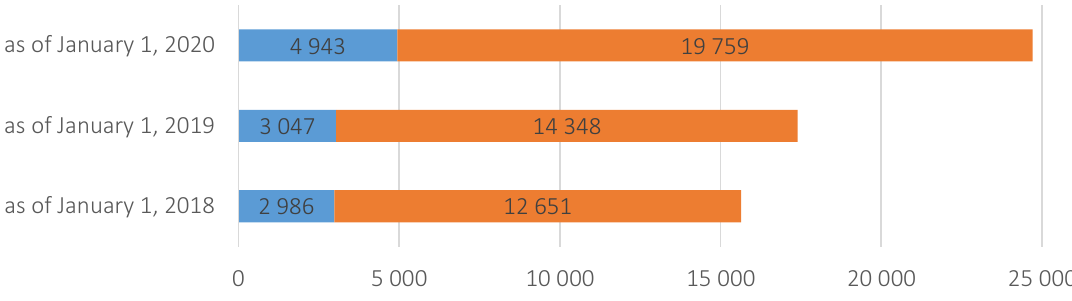
Figure 4. Number of warnings from the State Treasury Service of Ukraine’s bodies to managers and recipients of state and local budgets about improper fulfillment of budget legislation, number of